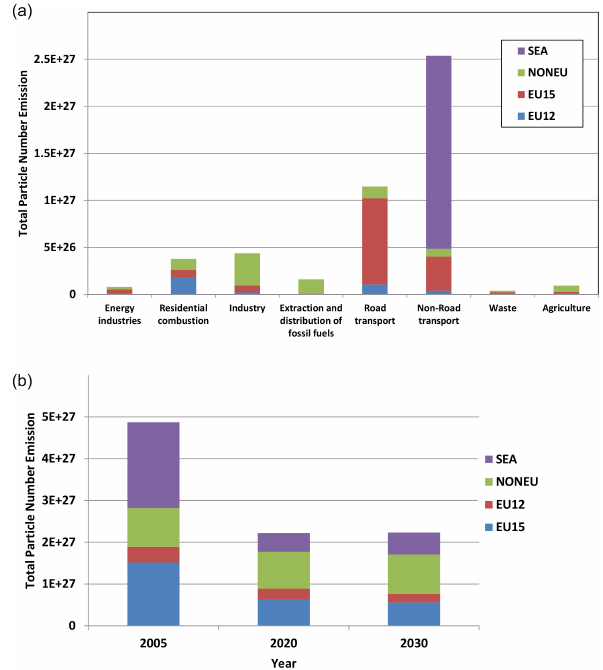
Figure 2. Total anthropogenic particle number emissions in the United Nations Economic Commission for Europe, (a) classified by the source sector for 2005, and (b) classified by the country group for 2005, 2020, and 2030. “Sea” refers to international